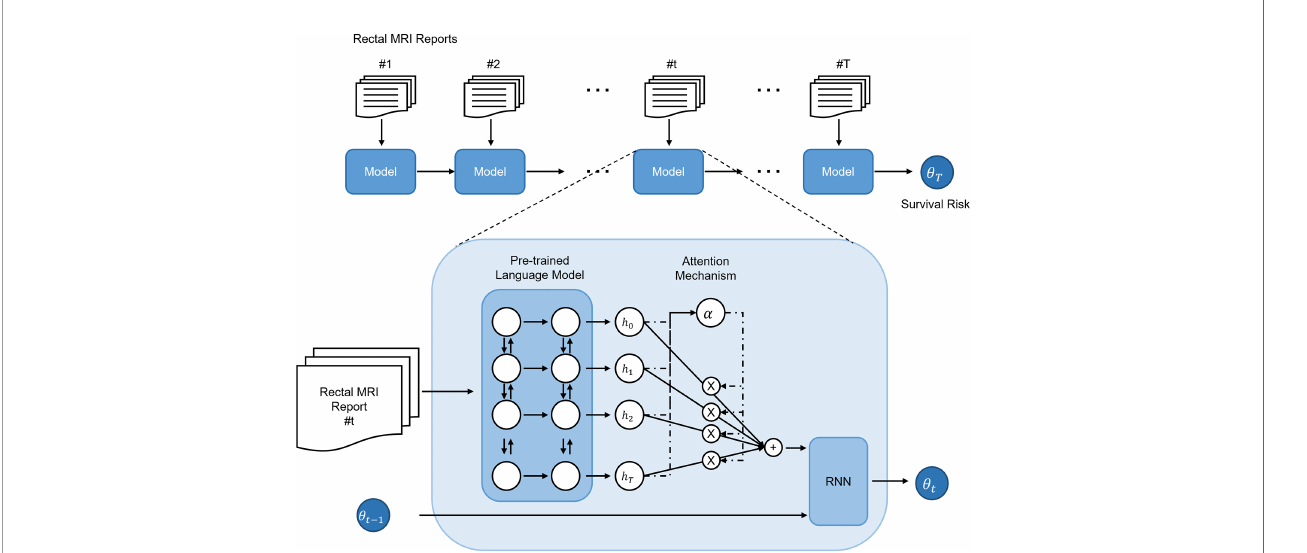
FIGURE 1 | Structure and risk strati fi cation of the deep-transfer-learning model. The radiological report of a patient is fi rst converted into an embedding vector using a pre-trained language model and attention mechanism. If the patient has multiple serial radiological reports, a recurrent neural network (RNN) model aggregates the embedding vectors of the serial reports and generates an embedding vector that represents the patient. Based on the patient embedding vector, a Cox-proportional hazards model predicts the patient ’ s survival